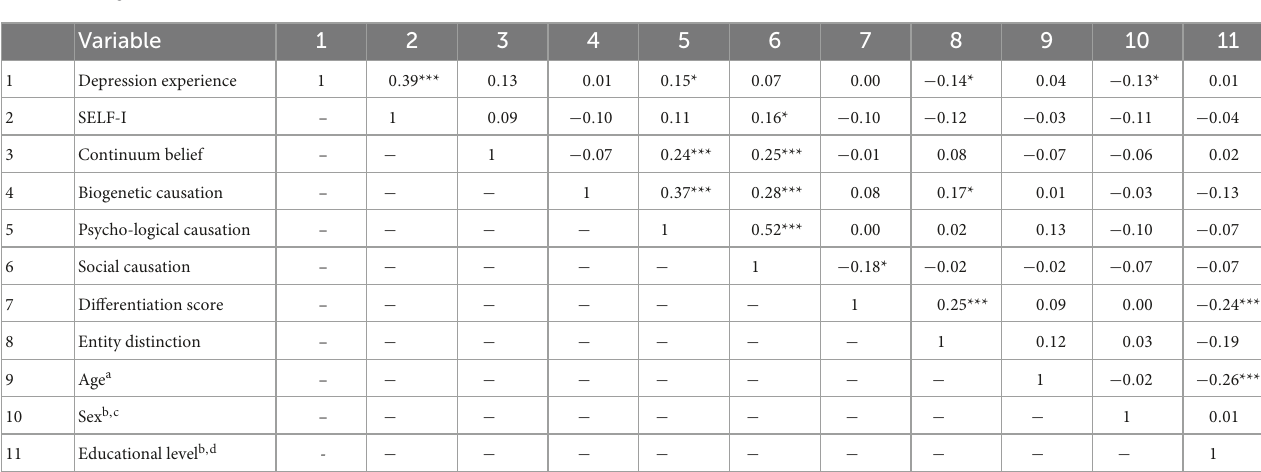
TABLE 3 Study variable